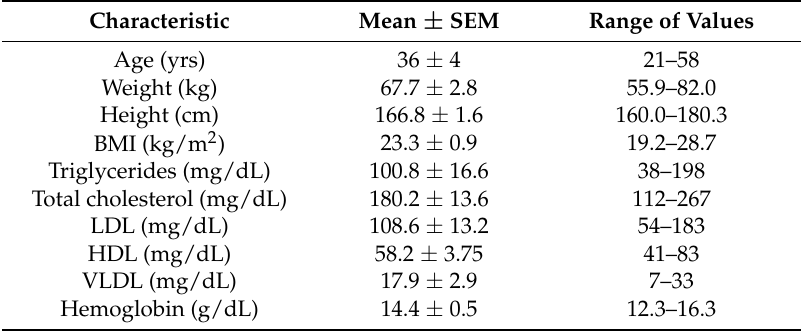
Table 2. Descriptive characteristics of women at study entry ( n =